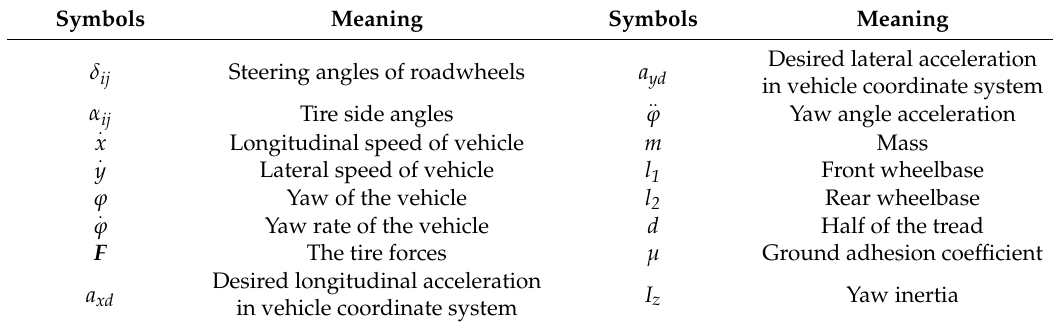
Figure 8. The schematic of FWIDSV. Table 2. The meaning of the symbols.